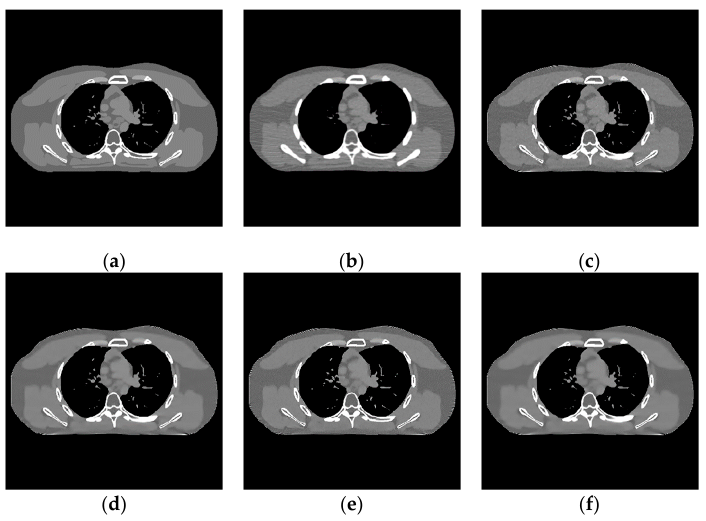
Figure 5. Experimental results of incident photon number 10 5 . ( a ) real image; ( b ) FBP reconstruc- tion image; ( c ) EP iterative reconstruction image; ( d ) DCT image post-processing; ( e ) DL iterative reconstruction; ( f ) learning sparse transform.